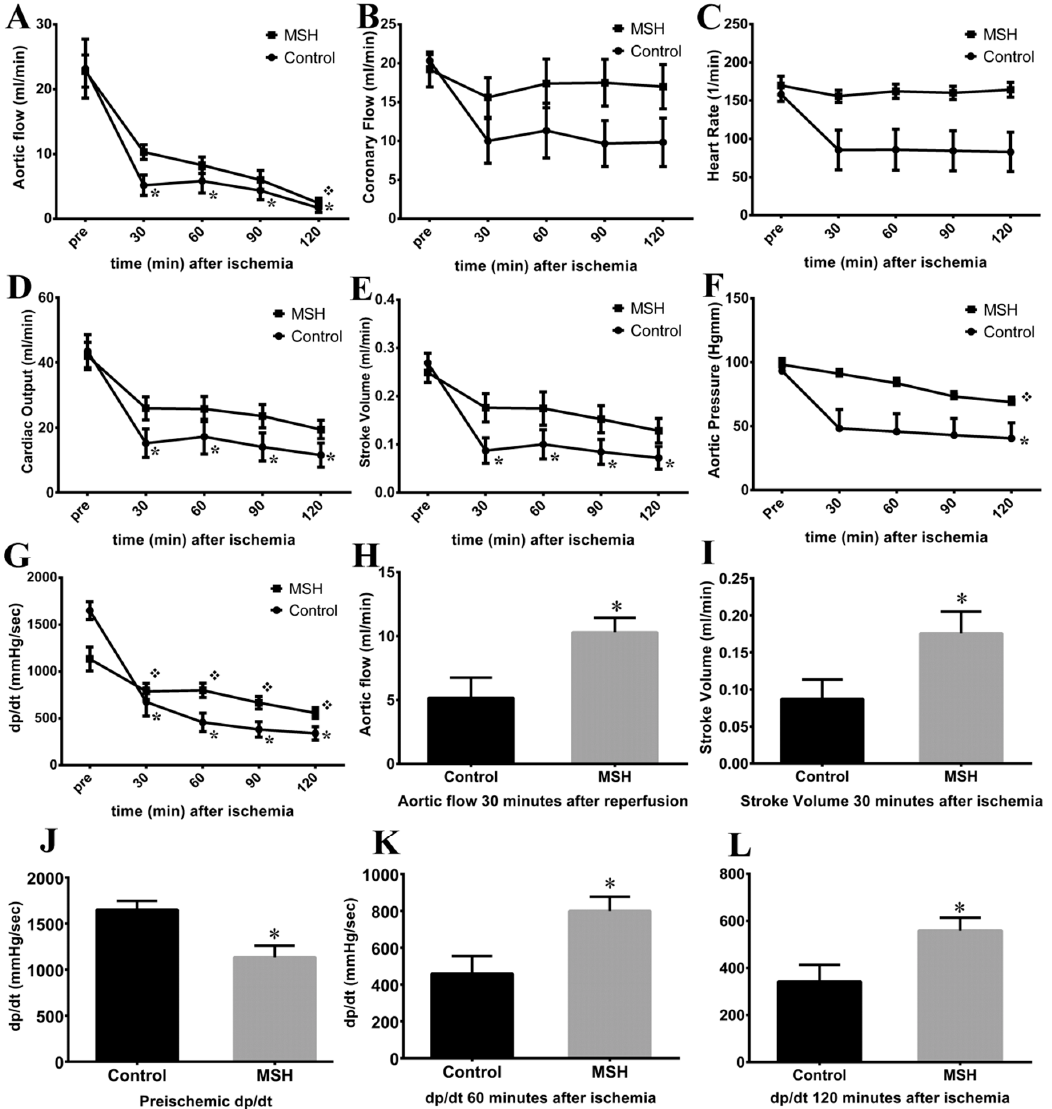
Figure 2. Results of the isolated working heart method. ( A ) aortic flow values; ( B ) coronary flow values; ( C ) heart rate values; ( D ) cardiac output values; ( E ) stroke volume values; ( F ) aortic pressure values; ( G ) dp/dt values; ( H ) aortic flow 30 min after reperfusion; ( I ) stroke volume 30 min after reperfusion; ( J ) pre-ischemic dp/dt values; ( K ) dp/dt 60 min after reperfusion; ( L ) dp/dt 120 min after reperfusion;